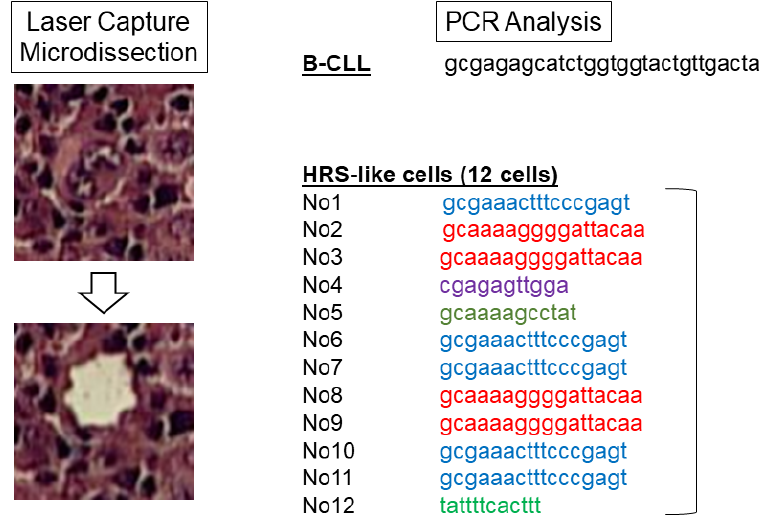
Figure 2. The sequencing pattern of the germline CDR3 region of the IGH gene. Left panel: representative laser microdissection of Hodgkin/Reed–Sternberg (HRS) cells within the lymph node is shown. Right panel: sequence trace in the germline complementary determining region (CDR)3 region of the IGH gene from a laser-captured B-CLL cell or each HRS cell is shown.